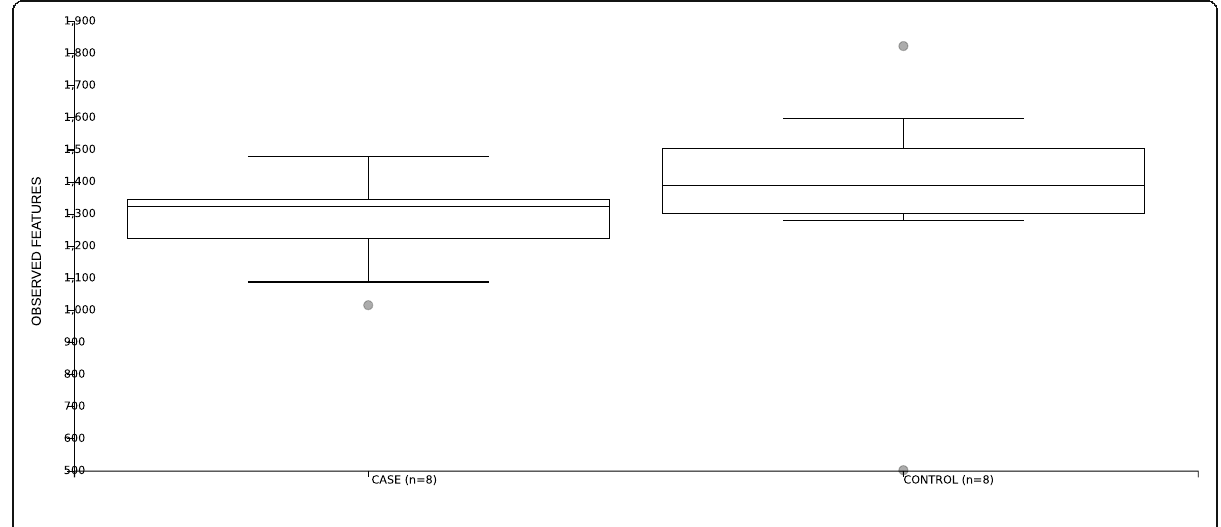
Fig. 11 Box and whisker plot of alpha diversity as measured by observed ASVs for samples taken from healthy sheep ’ s feet that did (case) or did not (control) develop CODD